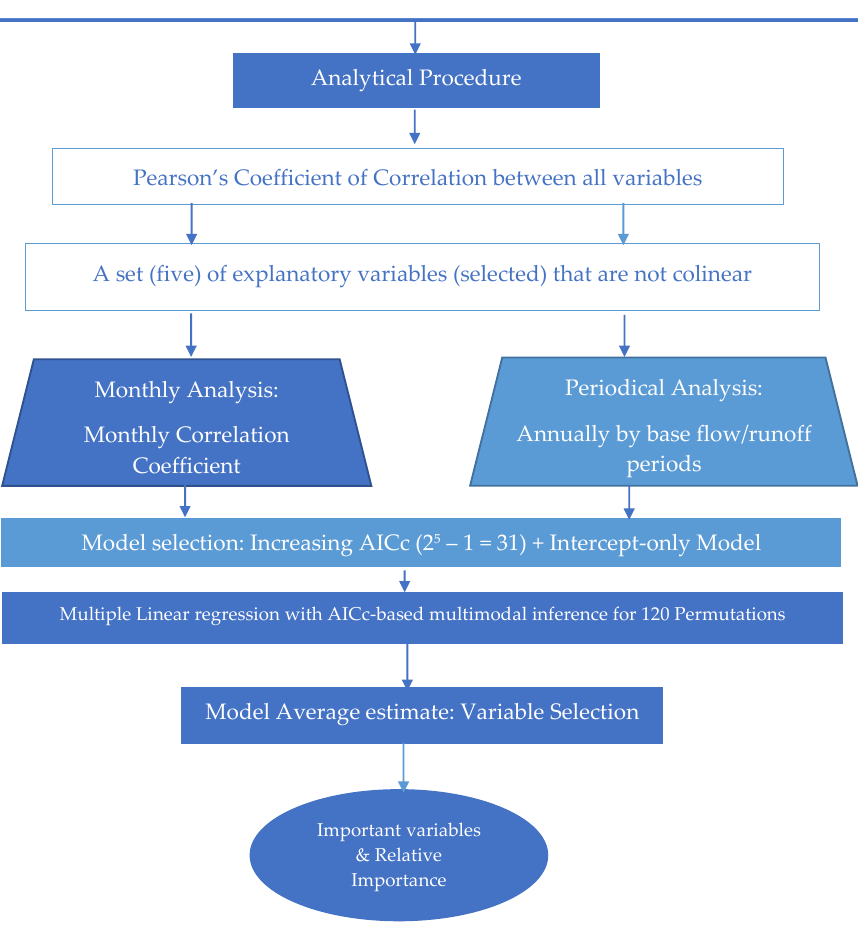
Figure 3. Procedural Flowchart of the analytical process .